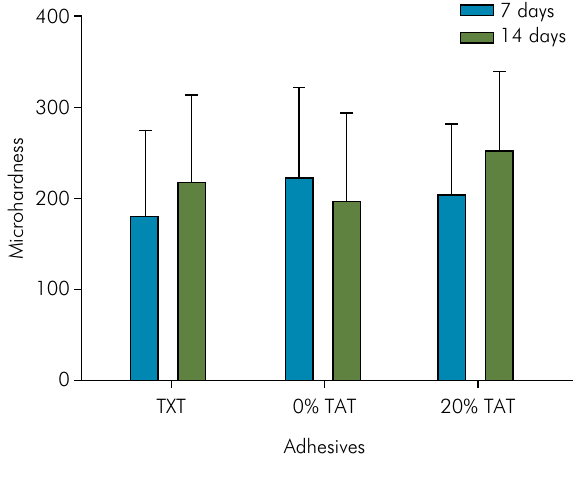
Figure 2. Mean and SD values of enamel microhardness according to time (7 and 14 days) and adhesive (TXT, 0% TAT, and 20% TAT).